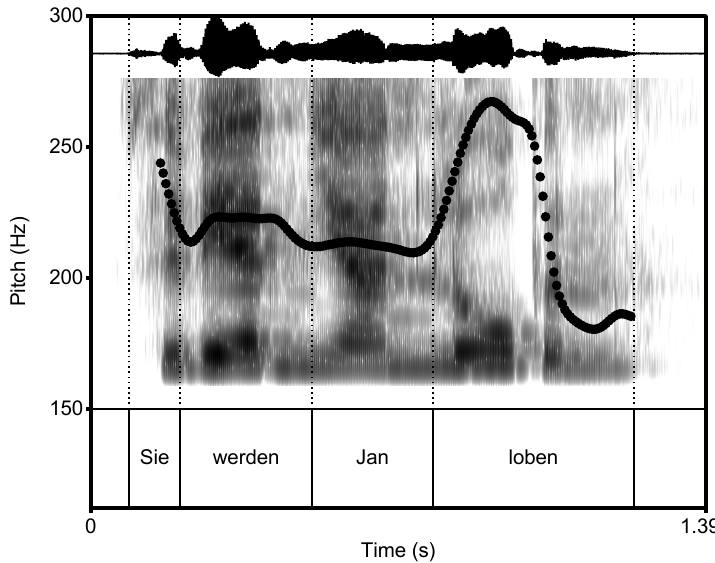
Figure 2. Pitch track, spectrogram, and waveform of a production of the sentence Sie werden Jan loben ‘They will praise Jan’ (20) where the object and verb ( Jan loben ) are focused and the object ( Jan ) is given.